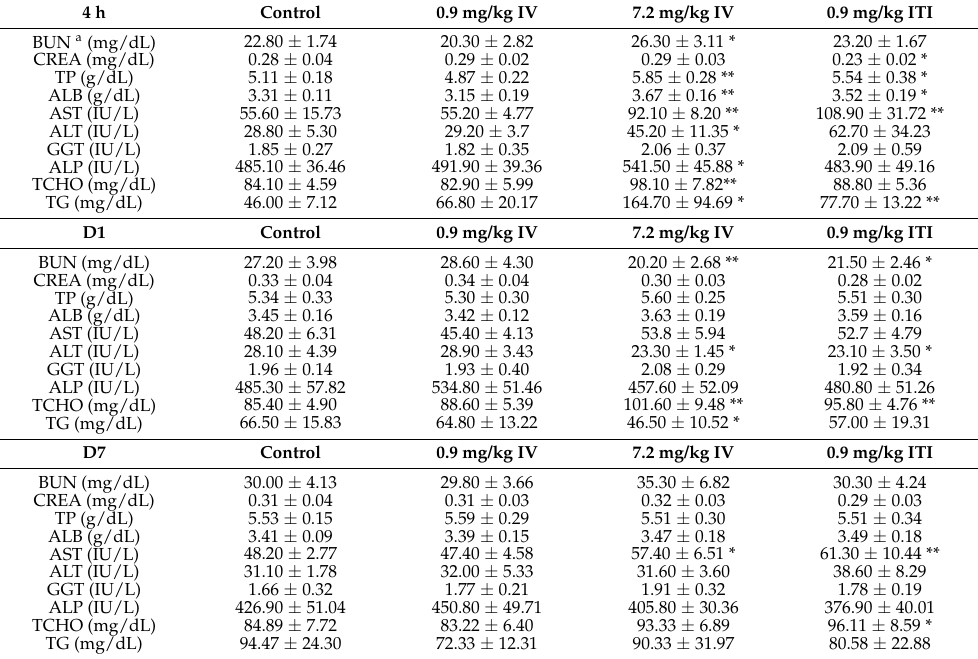
Table 2. Changes in serum chemistry following exposure to PHMG-P. 4